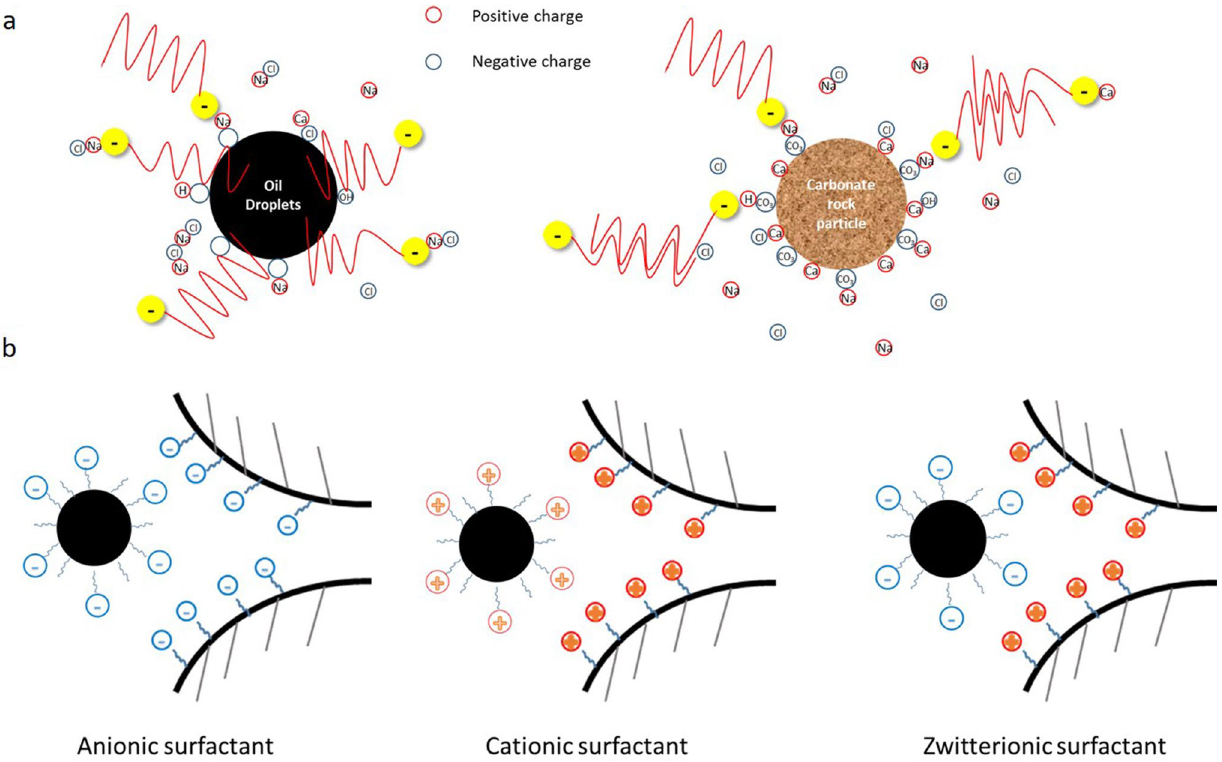
Figure 7. ( a ) The scheme of zeta-potential of oil droplets (left) and carbonate rock particles (right) in anionic surfactant and brine solutions; ( b ) the scheme transportation of charge oil droplets in charged porous